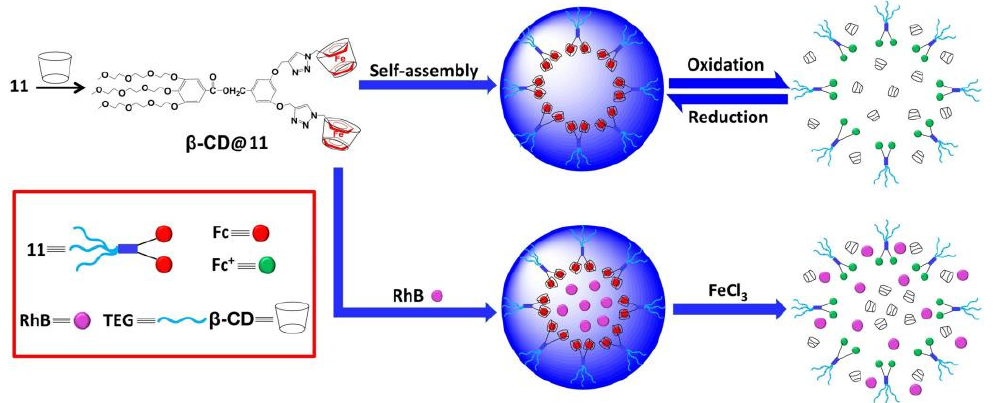
Figure 1. The Janus supramolecule β -CD@11’s synthesis, redox-responsive self-assembly, drug loading, and oxidation-triggered release are shown schematically (reproduced with permission of Elsevier from ref. [28]).